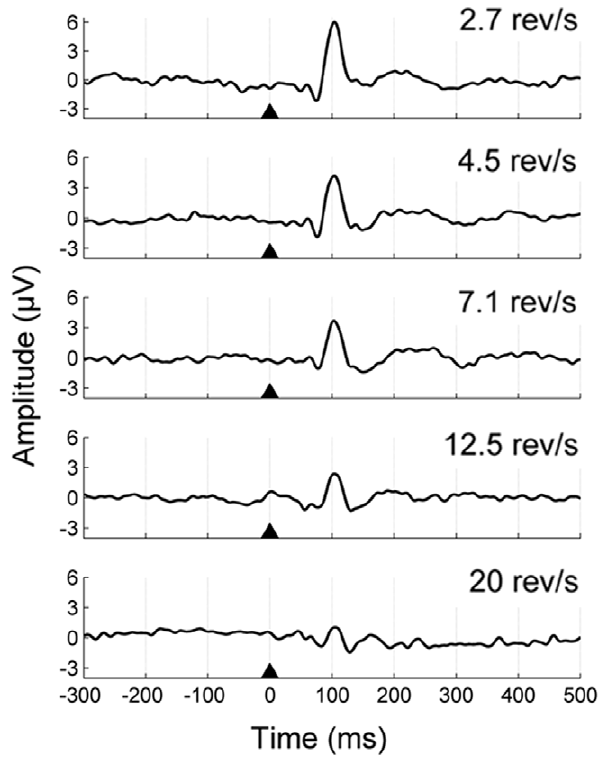
Figure 4. Templates of transient responses (Experiment 1). Grand-average waveforms (800 ms time window; 300 ms pre-stimulus) of the transient templates used to create the synthetic data at the five different rates. The transient templates correspond to the stimulus- locked average of the jitter conditions.